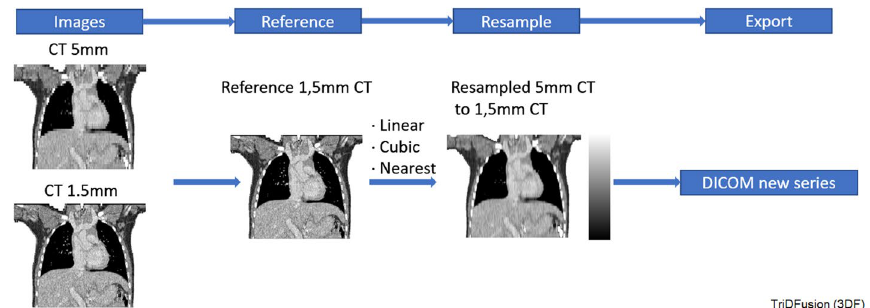
Fig. 6 Image resampling workflow using two computed tomography (CT)